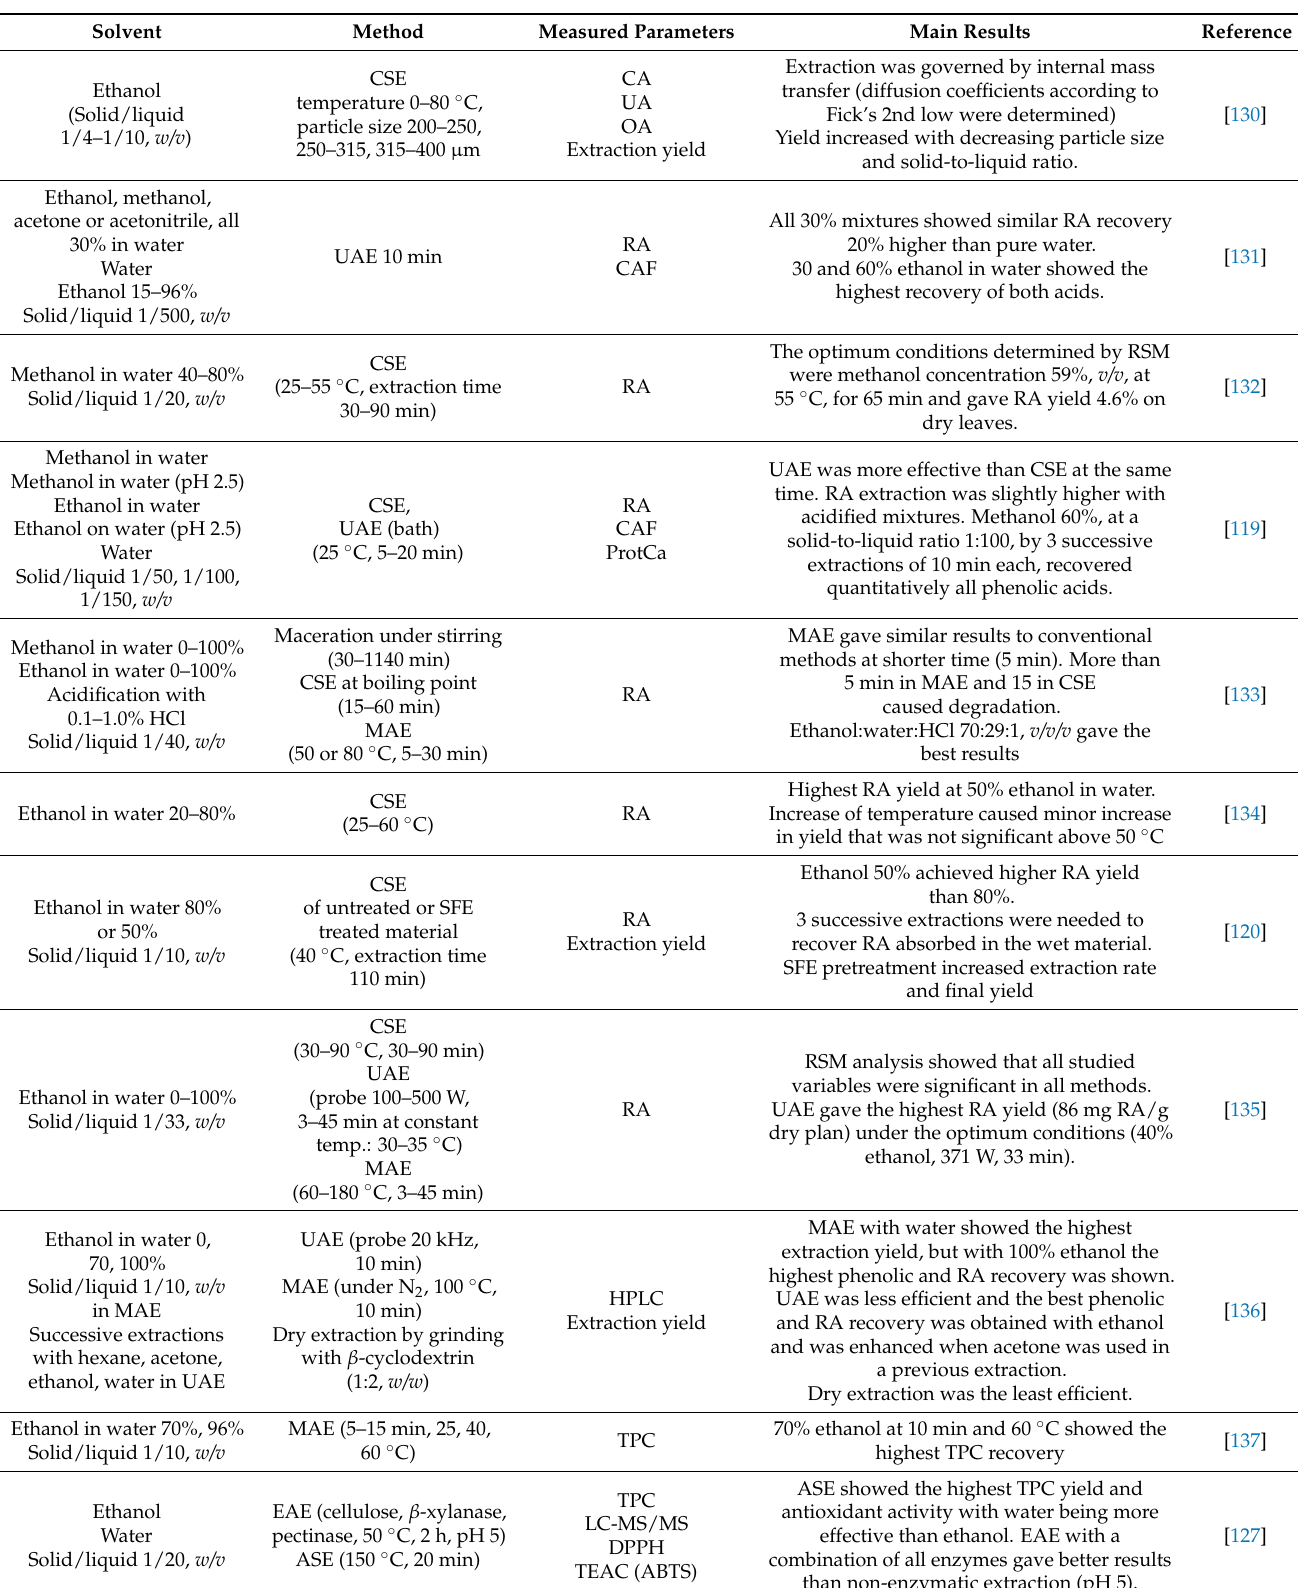
Table 4. Techniques and main results reported in literature for the extraction of phenolic compounds from lemon